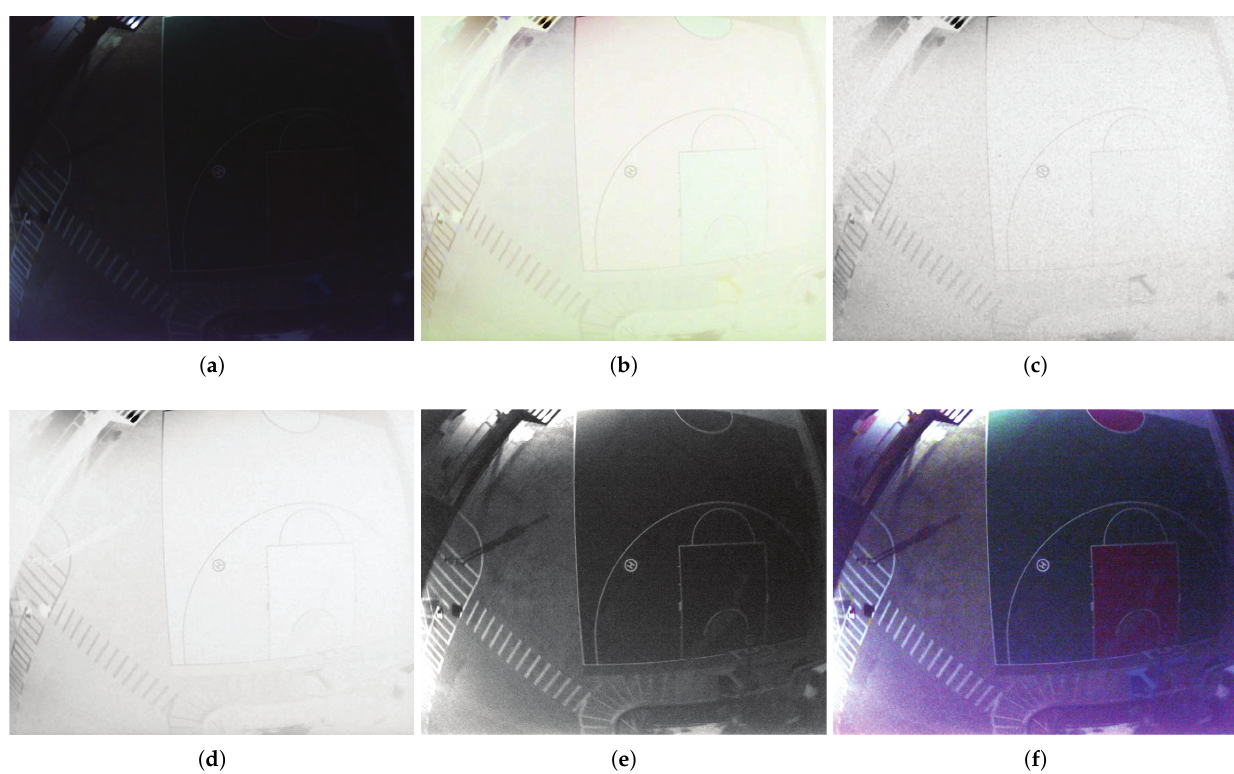
Figure 2. Low-illumination image enhancement: ( a ) Onboard captured low-illumination image. ( b ) Inverted low light image. ( c ) Result of dark channel calculation. ( d ) Result of luminance channel calculation. ( e ) Grayscale image after enhancement. ( f ) Color image after